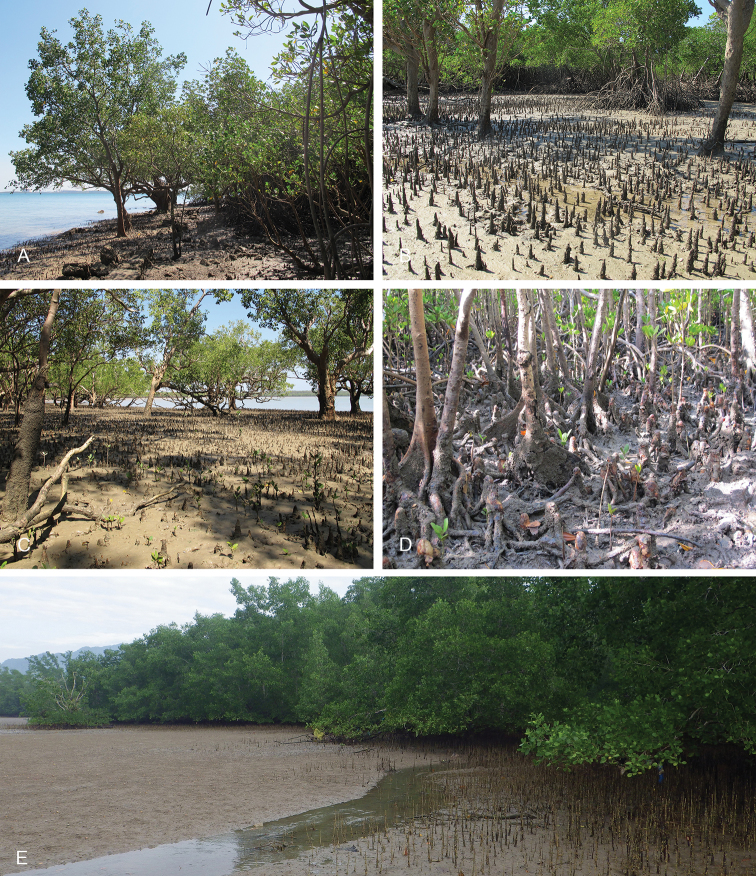
Habitats, Laspionchis
bourkeiA–DL.
bourkei
bourkei Australia, Northern Territory EL.
bourkei
lateriensis, Indonesia, Ambon. AAvicennia on sandy mud (st 61, type locality) B same as A C large Sonneratia
alba, open forest, soft mud by shore (st 62) DSonneratia, Rhizophora, and Ceriops mangrove (st 66) E mudflat beside a mangrove and a creek (st 128, type locality).